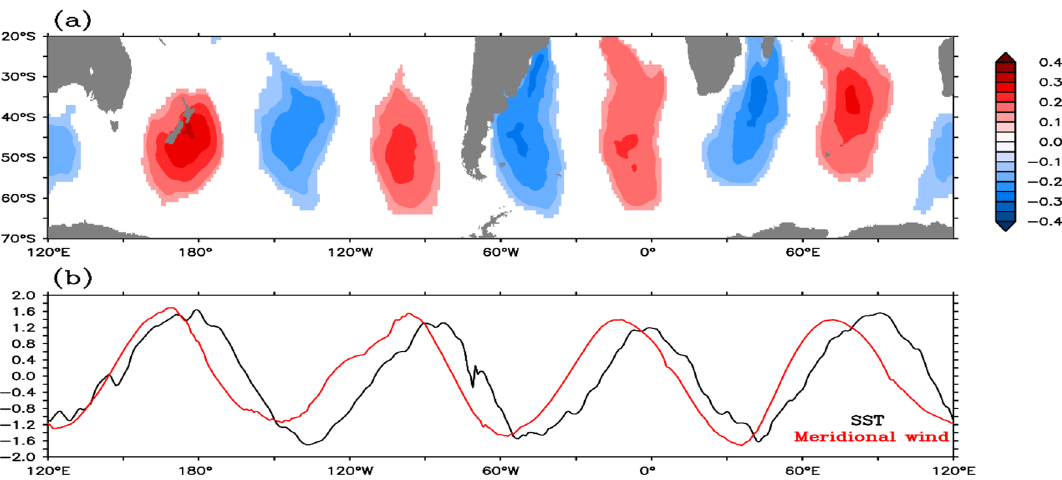
Figure 6. ( a ) Correlation field of above 99% significant between IW4 and meridional wind anomaly at 850 hPa. ( b ) Meridional average of SST (black line; − 1 is multiplied to avoid opposite relation) and meridional wind (red line) from 20 to